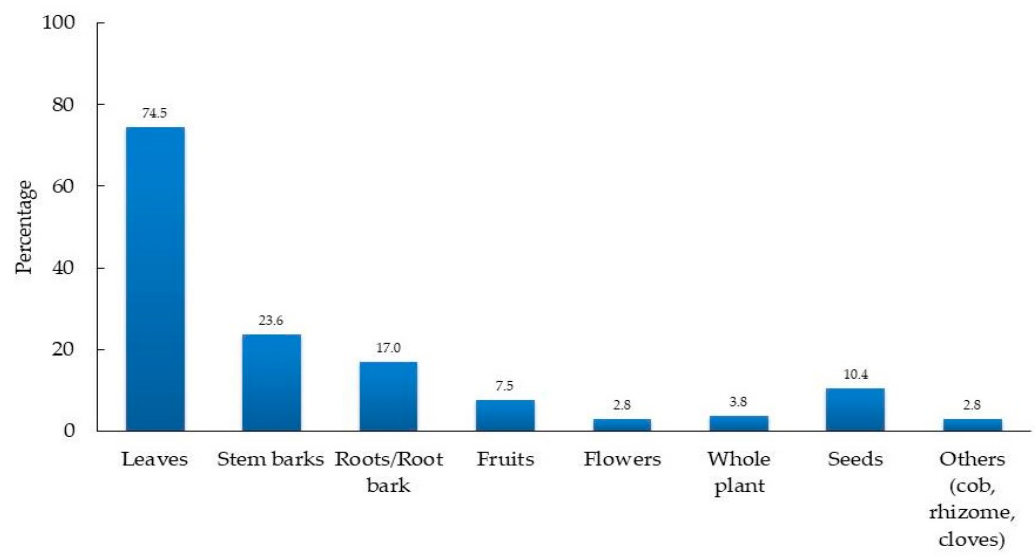
Figure 4. Plant parts used by informants for medicinal purposes.